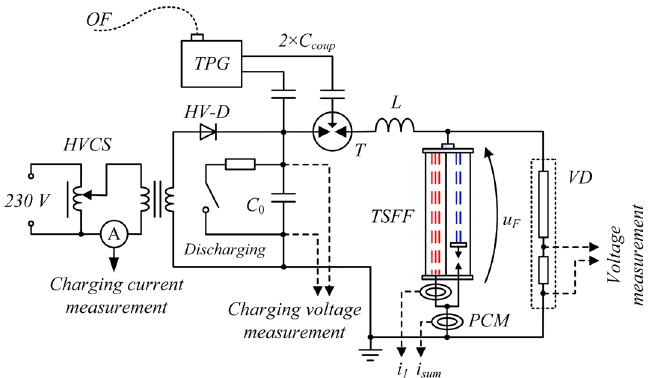
Figure 12. Schematic diagram of the TSFF-based PFS laboratory test stand: C 0 = 200 μF—battery of pulse capacitors charged to initial voltage U C0 = 10 kV, T trigatron, L = 2.8 μH—forming inductance, VD pulse voltage divider, PCM Pearson pulse current monitor, HV-D high voltage diode stack; HVCS high voltage charging system, TPG triggering pulse generator, OF optic fiber, C coup high voltage coupling capacitors, i 1 , i sum current of the preparatory stage and total current of the fuse, u F voltage across the fuse.